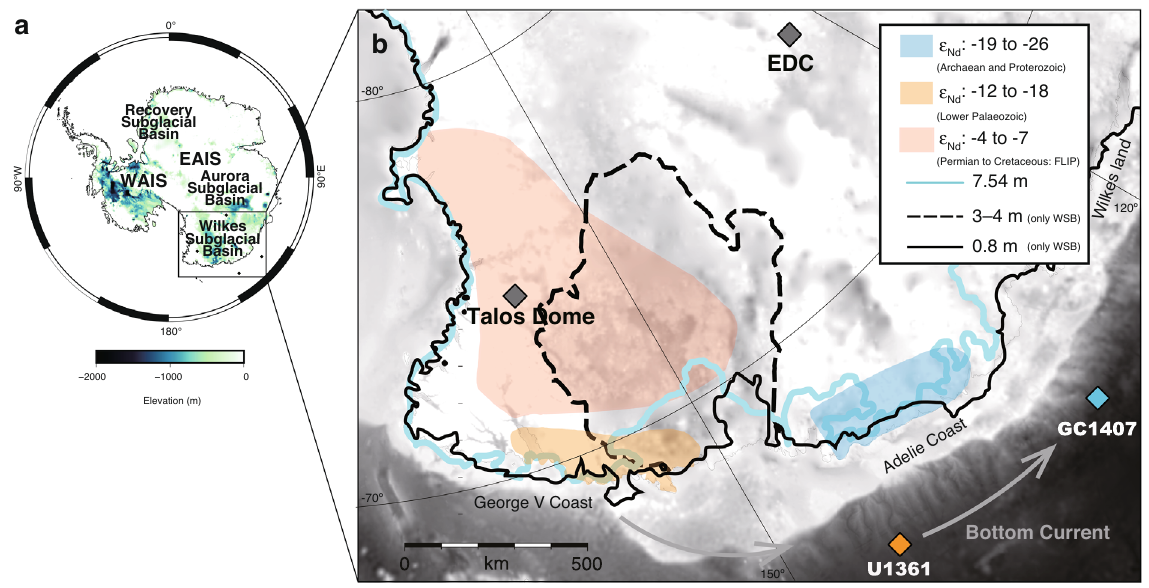
Fig. 1 | Regional setting of the Wilkes Subglacial Basin. a Map of Antarctica showing subglacial bedrock elevation below sea level 13 and locations of marine sediment cores and ice cores relevant to this study. Areas in white are above modernsealevelandshadedareasarebelowmodernsealevel.EAIS,EastAntarctic Ice Sheet. WAIS, West Antarctic Ice Sheet. b Detailed map of the Wilkes Subglacial Basin (WSB), with grey shading indicating bedrock elevation (as in panel a ) and coloured shading representing the simpli fi ed geographical extent of three geolo- gical terranes differentiated according to their neodymium isotope ( ε Nd ) char- acteristics (map redrawn from ref. 30). Also shown are the locations of relevant marine sediment cores (GC1407 and U1361A) and ice cores (Talos Dome; EDC,